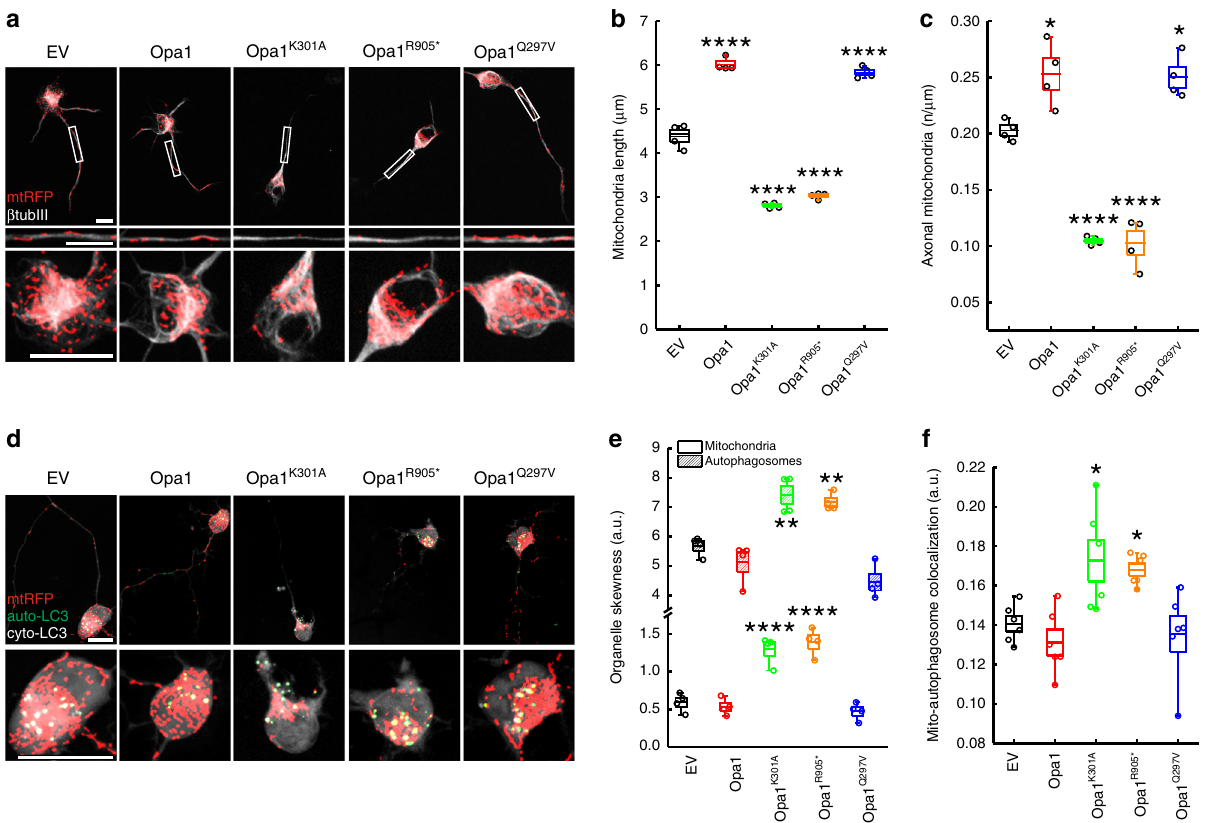
Fig. 1 Mitochondrial content is reduced in axons of ADOA RGCs. a Representative z-projections of stacks of confocal images of mtRFP (red) in primary RGCs co-transfected with the indicated plasmids and after 24h fi xed and immunostained with β -tubulin III ( β tub III, grey). Axons and somas were magni fi ed in the bottom panels. EV, empty vector. Bars, 20 μ m. b Quanti fi cation of mitochondrial length from four independent experiments as in ( a ) (EV, n = 86; Opa1, n = 113; Opa1 K301A , n = 82; Opa1 R905* , n = 71; Opa1 Q297V , n = 114 cells). **** p < 0.0001 vs. EV in one-way ANOVA/Tukey ’ s test. c Quanti fi cation of mitochondrial content in axons from four independent experiments as in ( a ) (EV, n = 58; Opa1, n = 65; Opa1 K301A , n = 69; Opa1 R905* , n = 54; Opa1 Q297V , n = 64 cells). * p = 0.018 Opa1, p = 0.027 Opa1 Q297V vs. EV; **** p < 0.0001 vs. EV in one-way ANOVA/Bonferroni ’ s test. d Representative z-projections